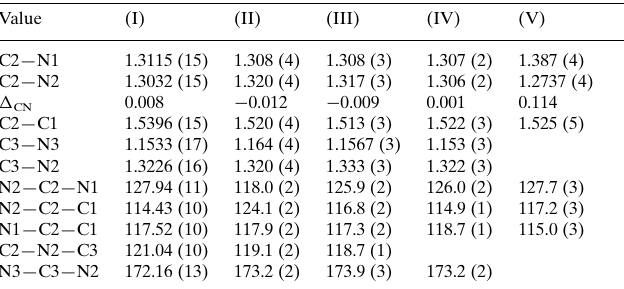
Comparative distances (A˚ ) and angles ( (cid:3) ) in amidines